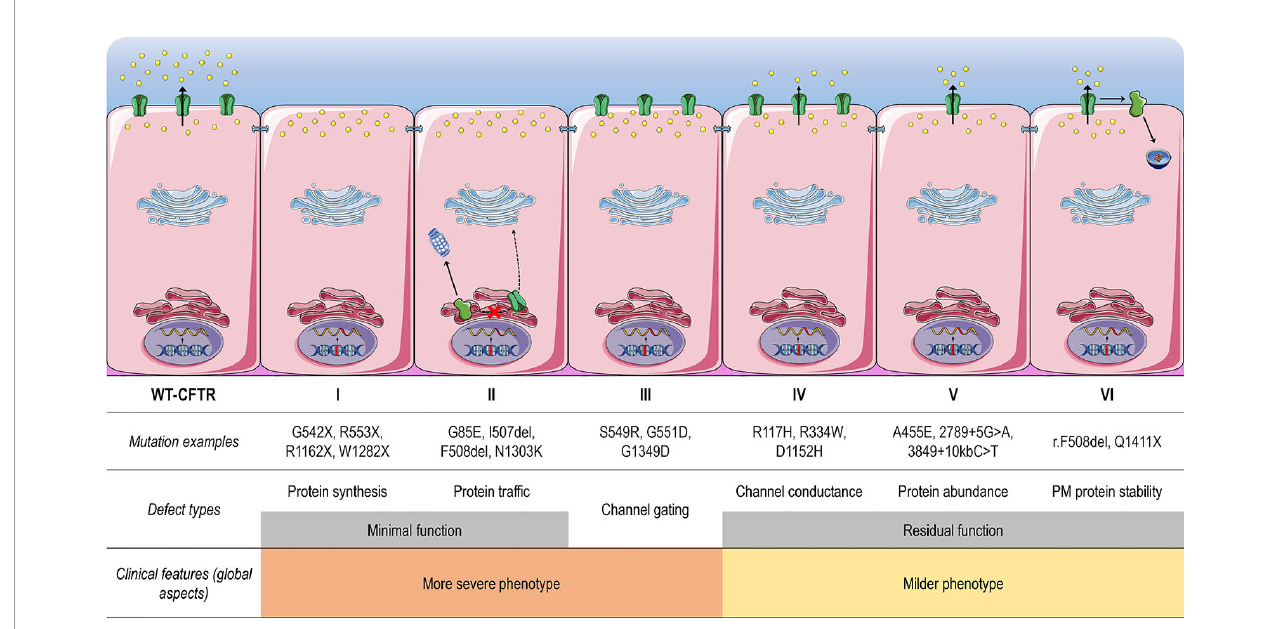
FIGURE 4 | Classes of CF transmembrane conductance regulator (CFTR) mutations. Class I mutations lead to no protein synthesis or translation of shortened, truncated forms. They result from splice site abnormalities, frameshifts due to deletions or insertions, or nonsense mutations, which generate premature